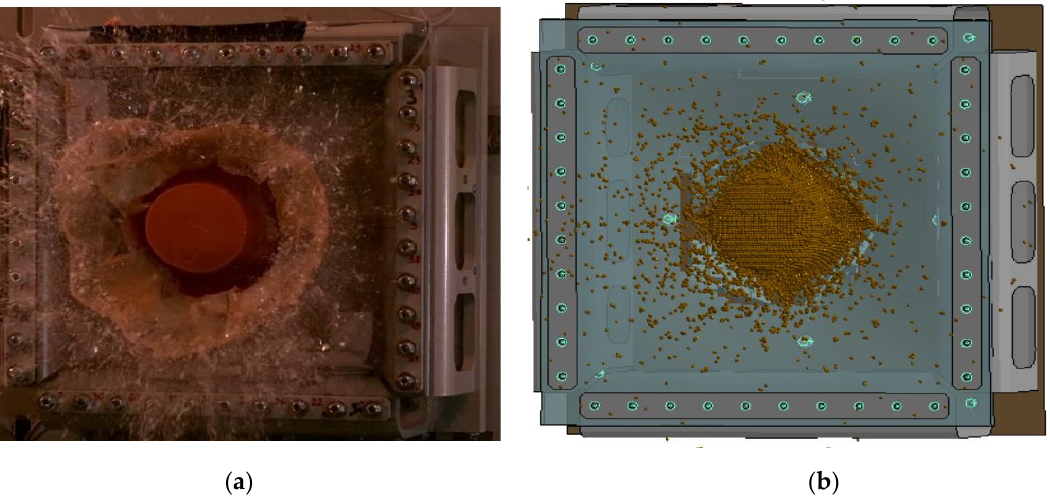
Figure 34. Comparison of the projectile and the plexiglass plate deformations for experimental ( a ) and numerical ( b ) studies.